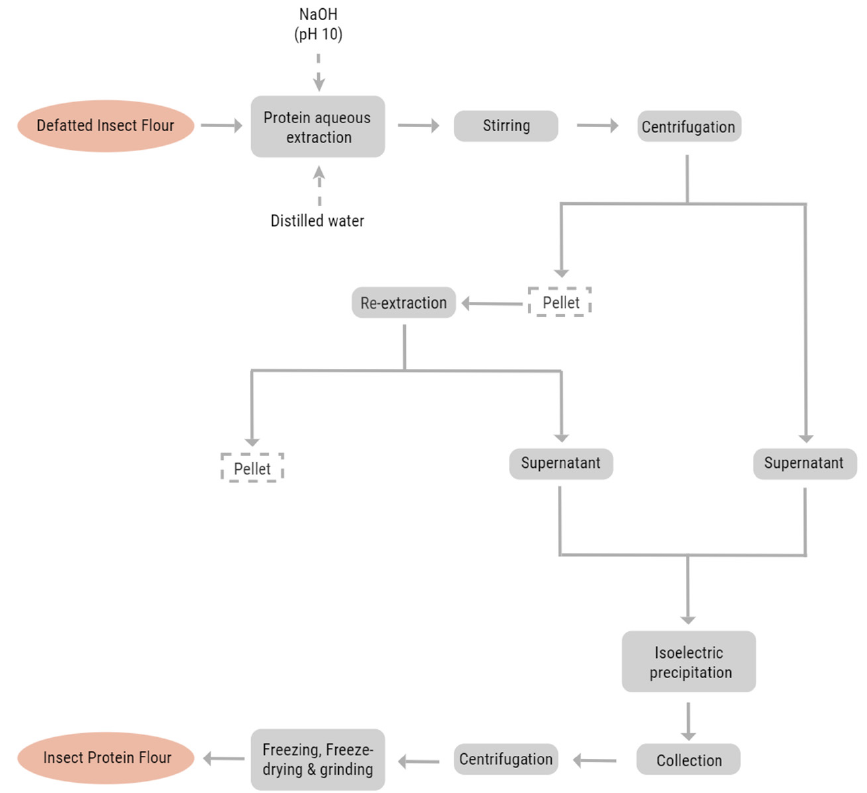
Figure 8. Schematic representation of insect protein extraction from defatted insect flour.